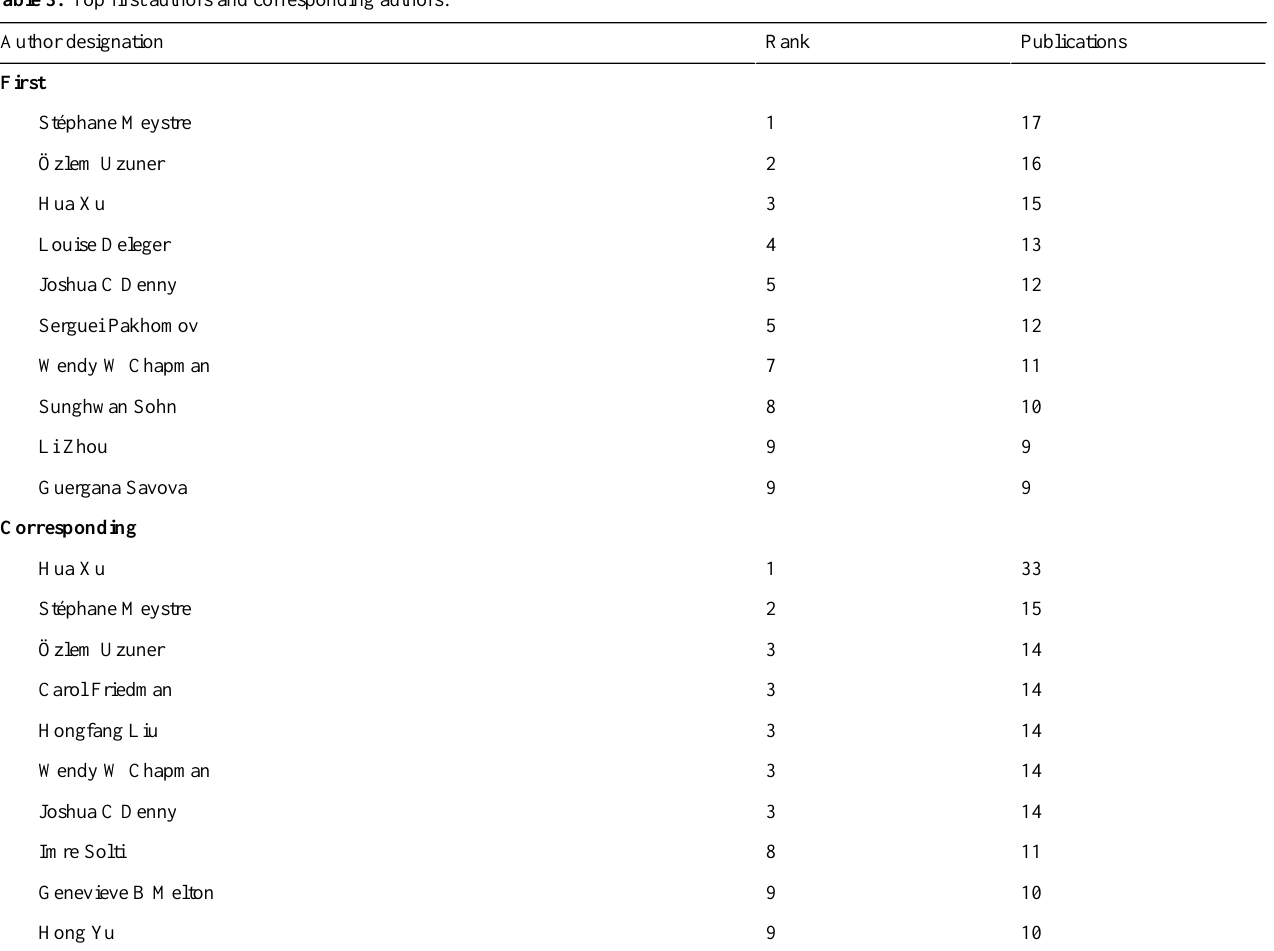
Table 3. Top first authors and corresponding authors.